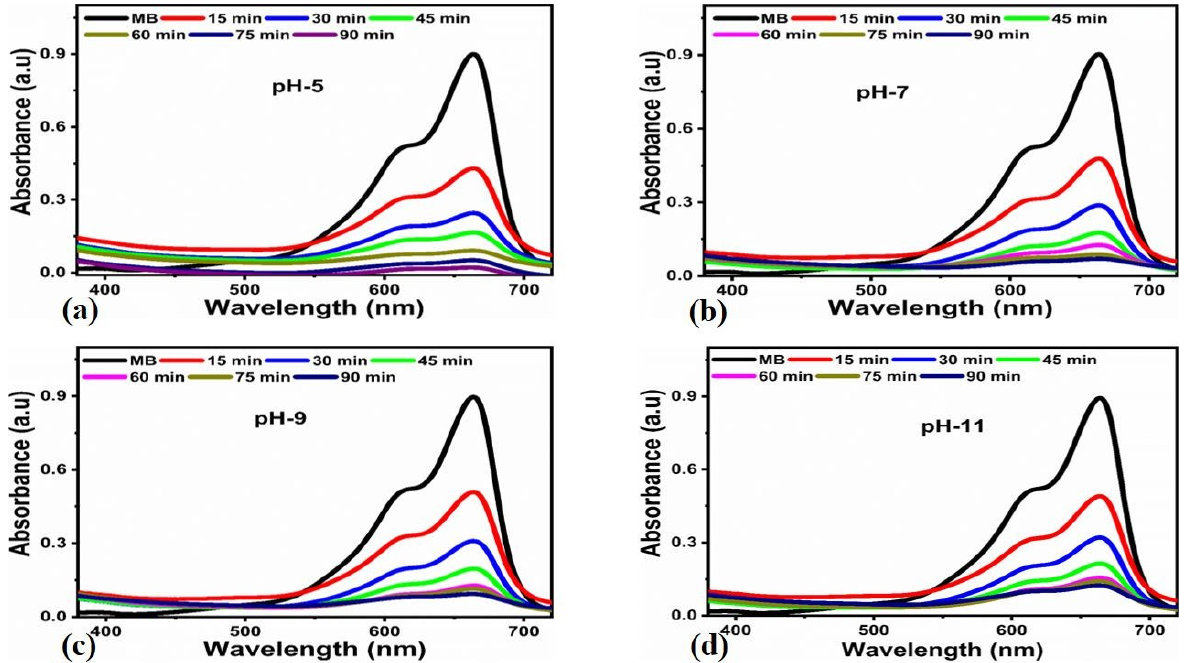
Figure 6. ( a – d ) UV-visible absorbance spectra measured in 2.3 × 10 −5 M MB solution with an adjusted pH of 5, 7, 9 and 11, using 15 mg of as-prepared carbon material under the irradiation of UV for 90 min.